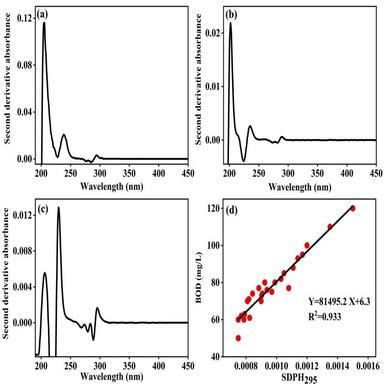
UV second derivative spectra of (a) BSA, (b) tyrosine and (c) tryptophan solution. (d) Correlation between SDPH295 and BOD of influent samples (n = 26). UV: ultraviolet; BSA: bull serum albumin; SDPH: second derivative peak height; BOD: biological oxygen demand.